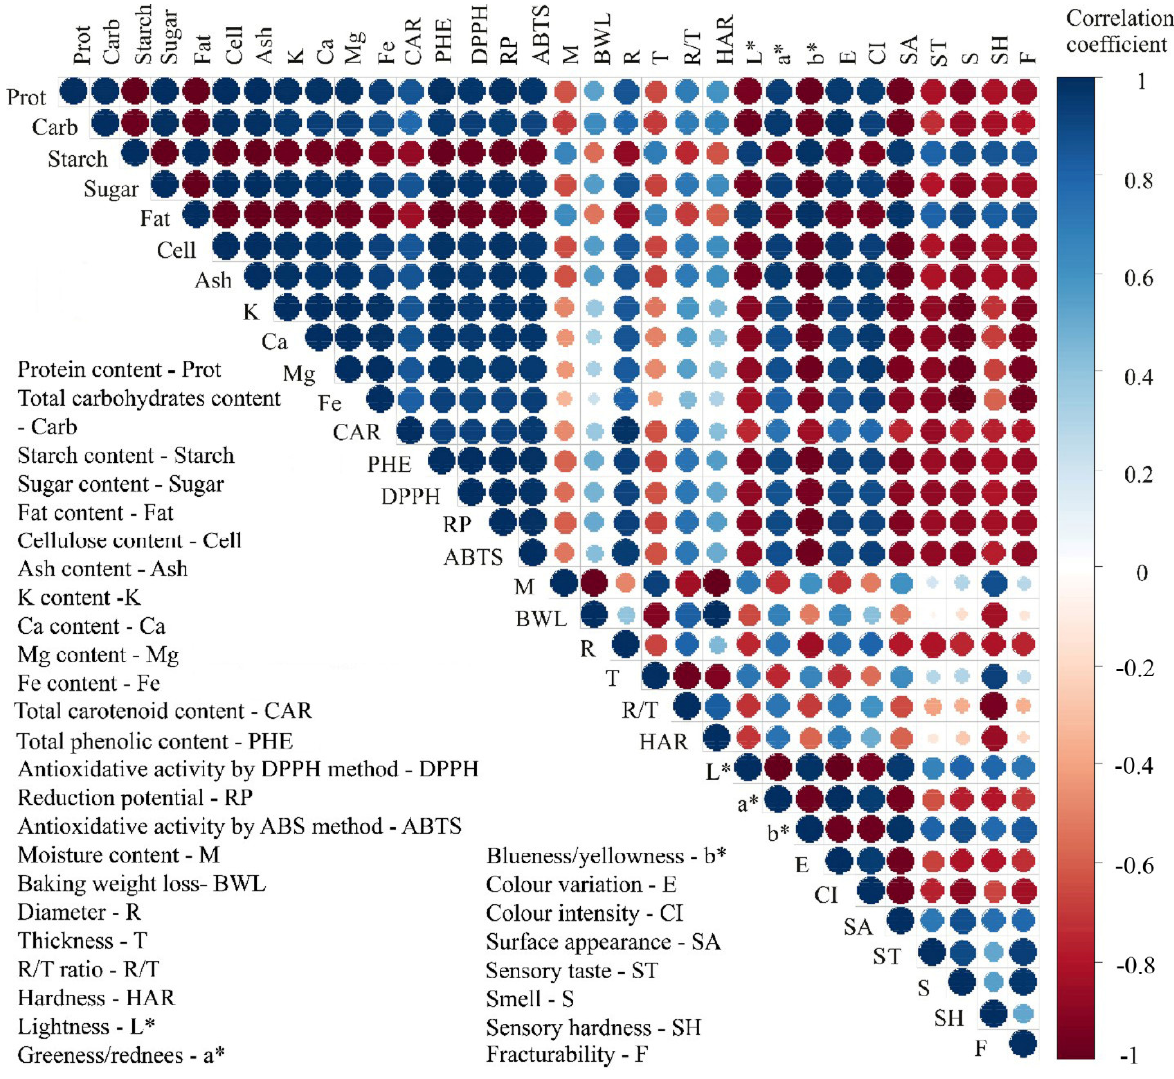
Figure 1. Colour correlation diagram between all 32 tested responses of cookies, with and without addition of L and OL peach.